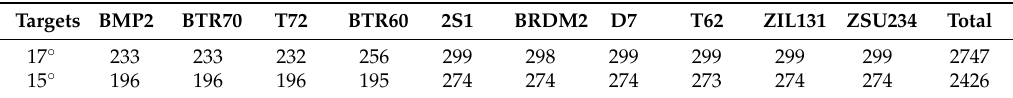
Table 2. Number of training samples and test samples.